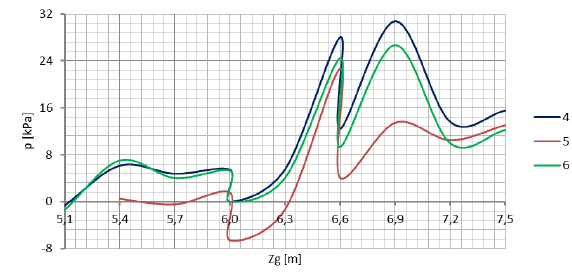
Figure 9: Plots of interfacial interactions along perimeter zone of shell.